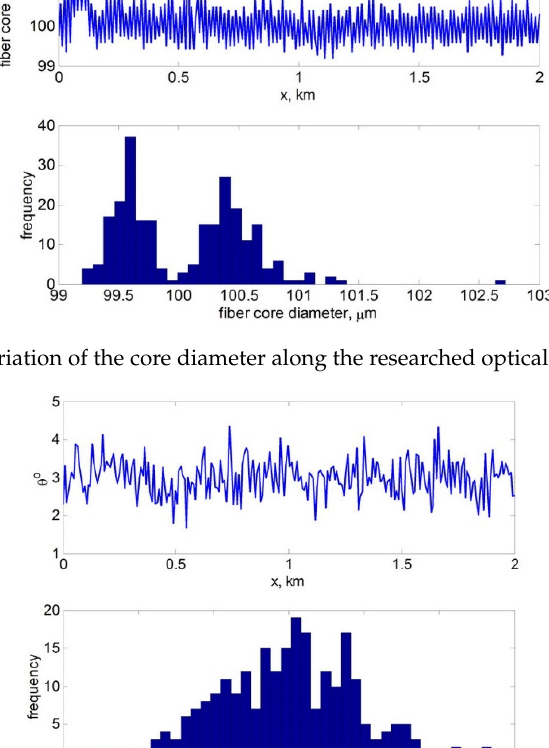
Figure 9. Variation of the equivalent angular misalignment at the splice of regular spans along the fiber length simulating fiber micro- and macro-bends.